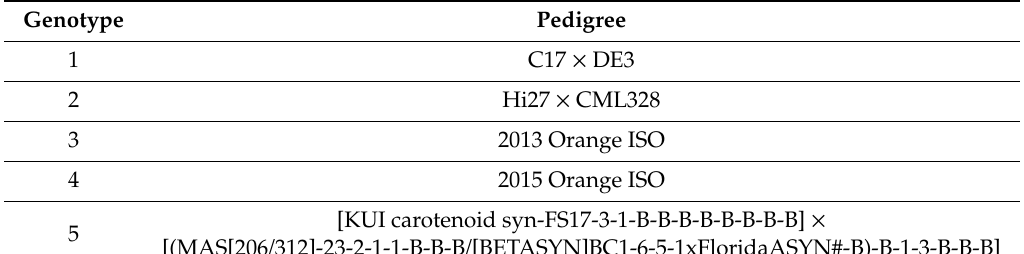
Table 1. Genetic pedigree of the genotypes